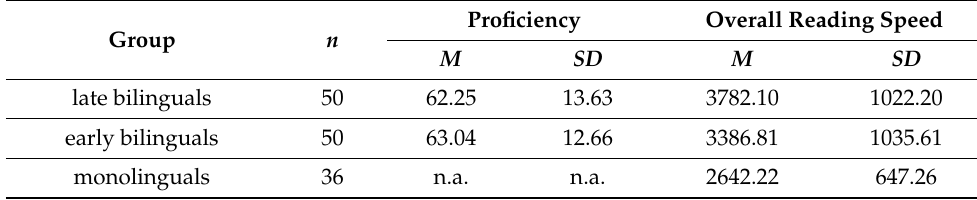
Table 1. Descriptive statistics for Spanish proficiency test and overall reading